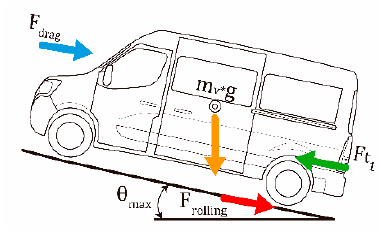
Figure 1. Forces distribution along longitudinal axis of the vehicle for case 1.